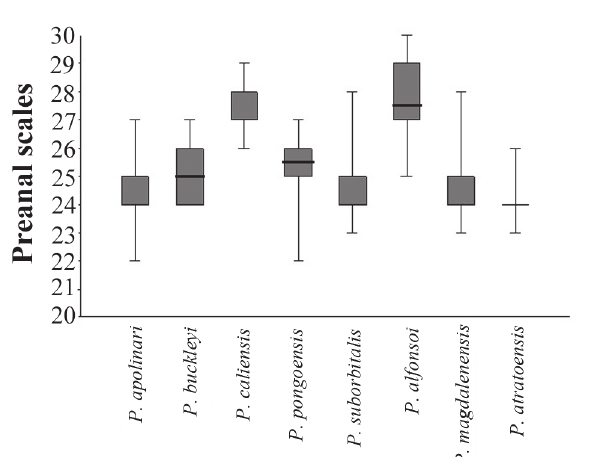
Fig. 14. Number of preanal scales of Colombian species of